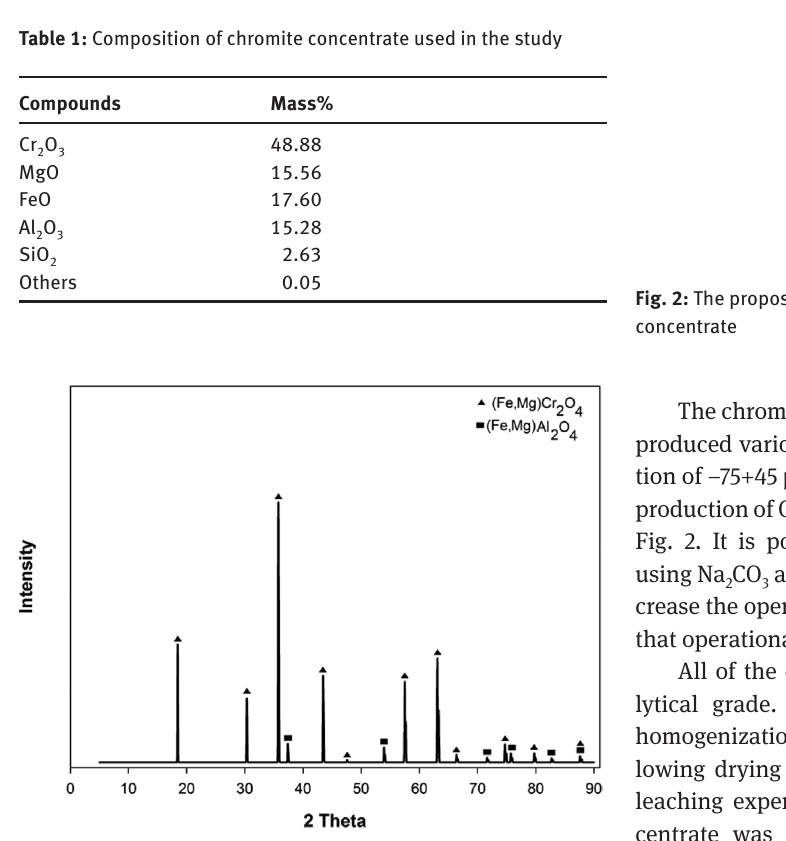
Fig. 1: XRD pattern of the chromite concentrate used in the